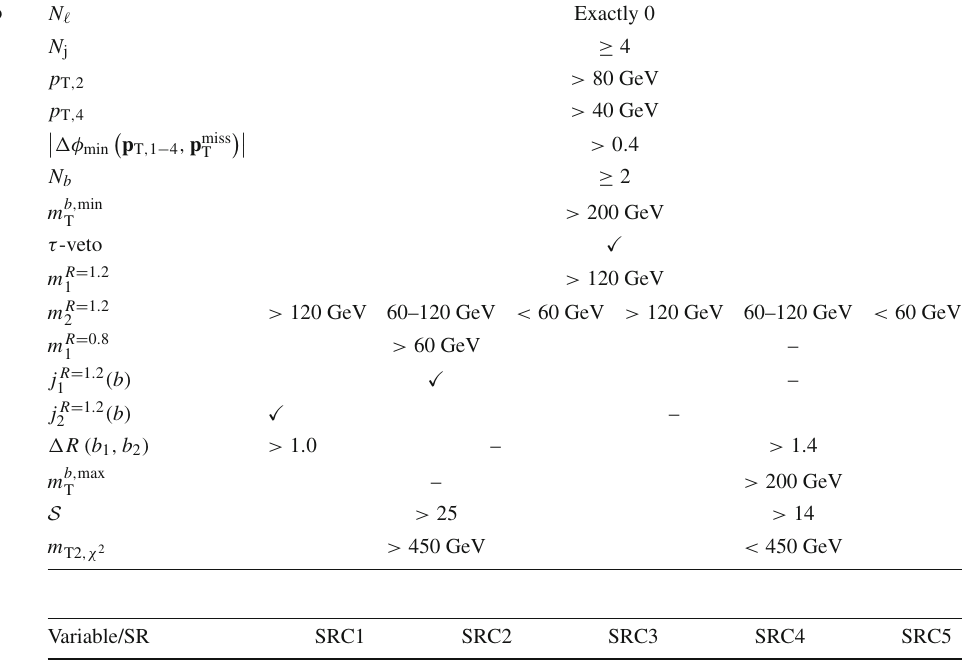
Table 3 Selection criteria for SRC. The signal regions are separated into five categories based on ranges of R